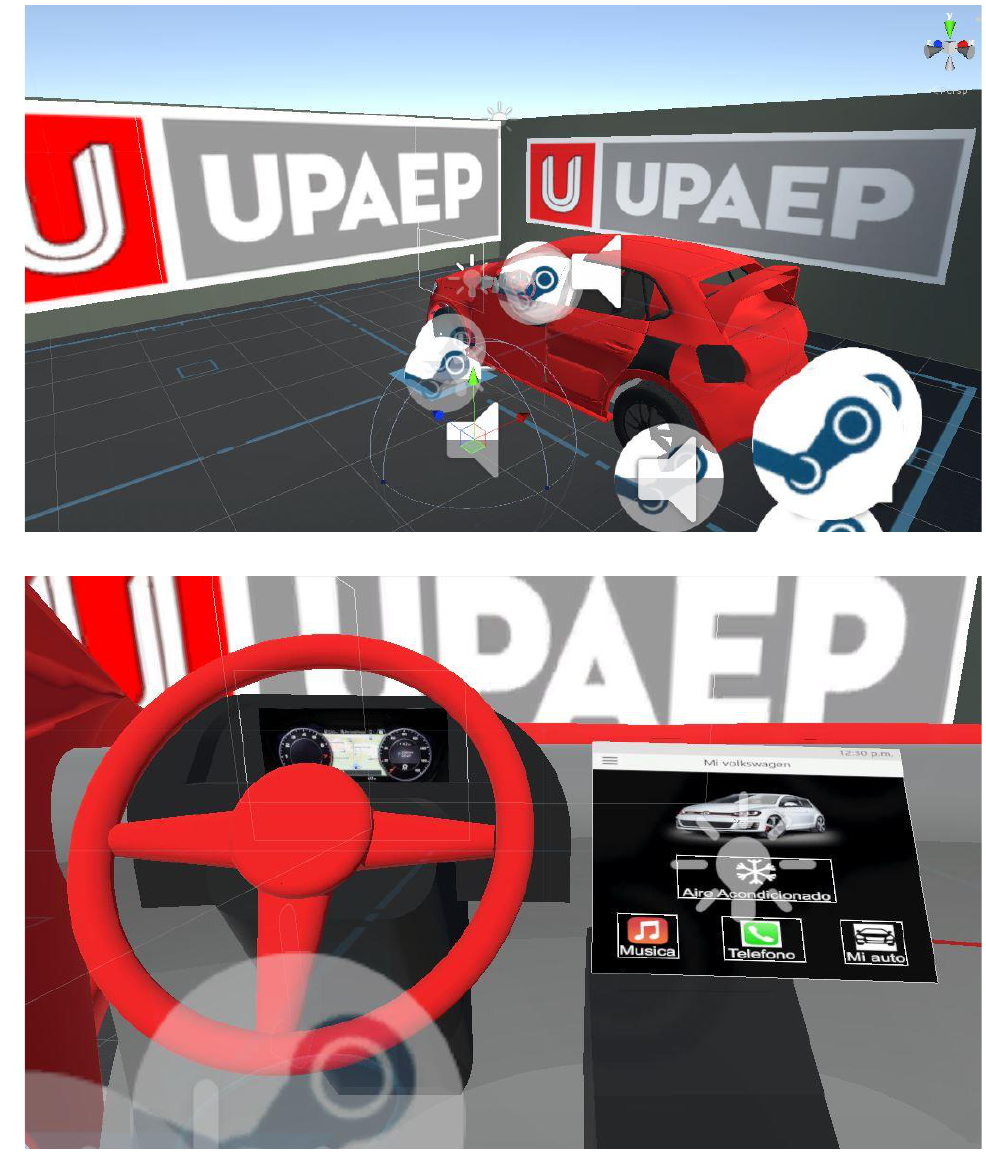
Figure 4. Immersive environment of complete-vehicle virtual model developed at the VR/AR laboratory at UPAEP